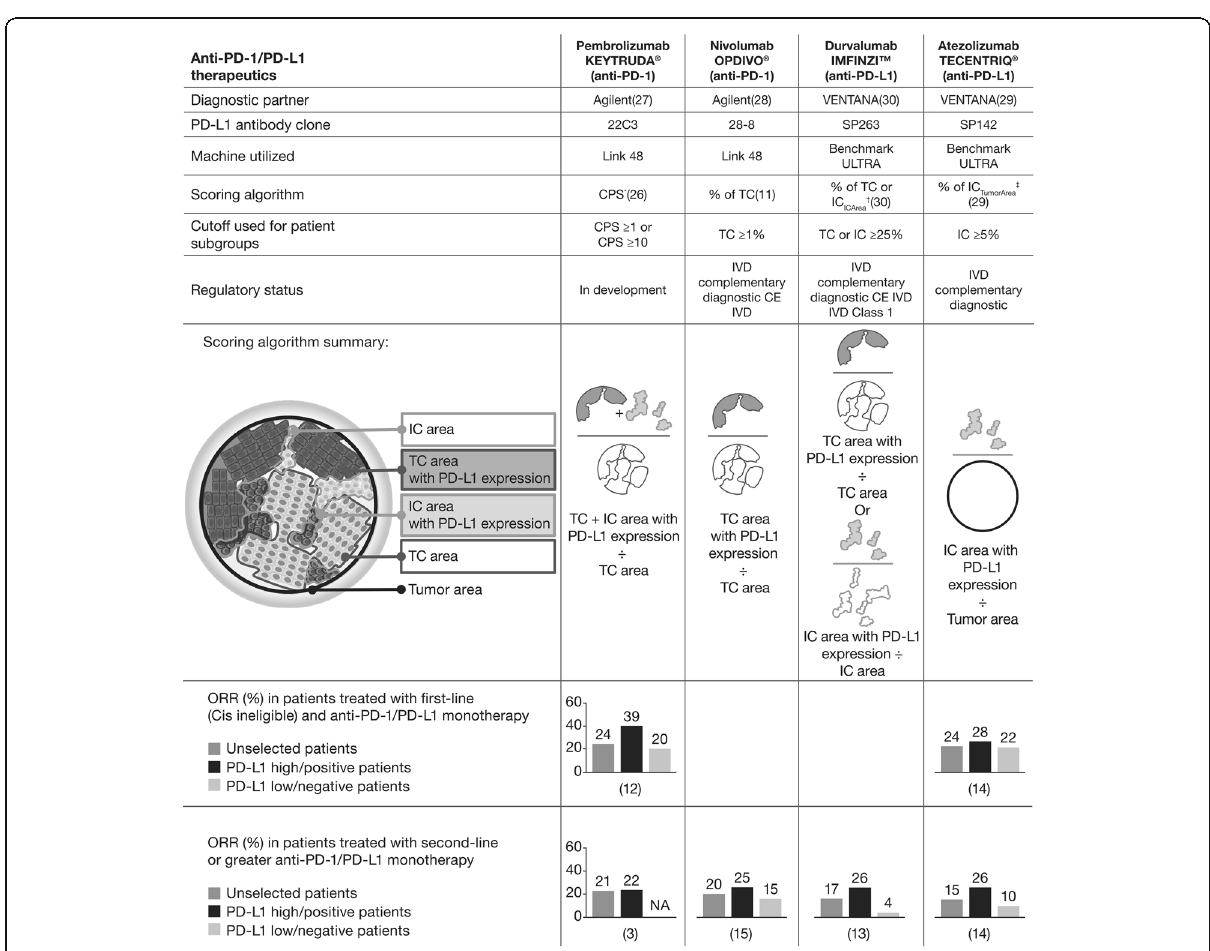
Fig. 1 Comparison of PD-L1 assays for UC and differences in immune cell measurement and scoring algorithm. *Ratio of tumor cells (TC) and immune cells (IC) relative to number of all TC. † IC score is the percentage area of ICs present exhibiting PD-L1 positive IC staining. ‡ IC score is the proportion of ICs that are PD-L1 positive, expressed in relation to tumor area. CE European Conformity, Cis cisplatin, IVD in vitro